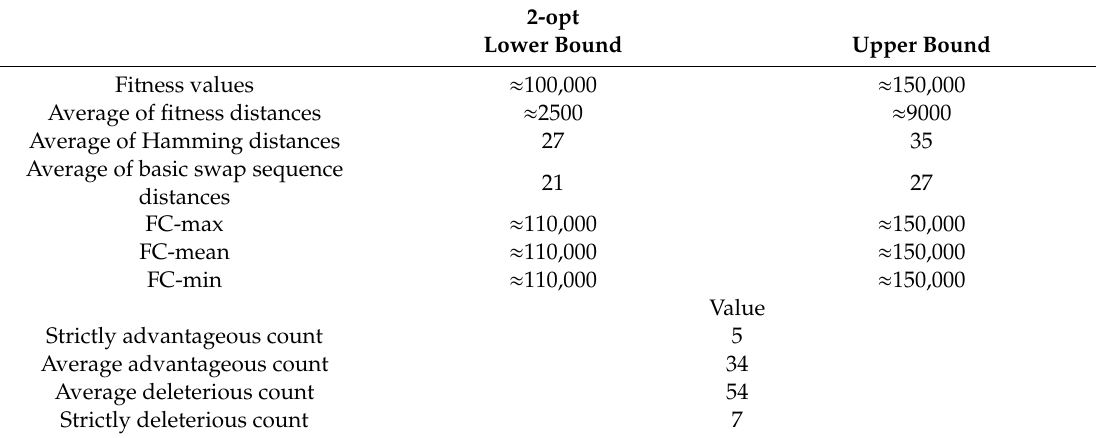
Table 6. 2-opt distances results.